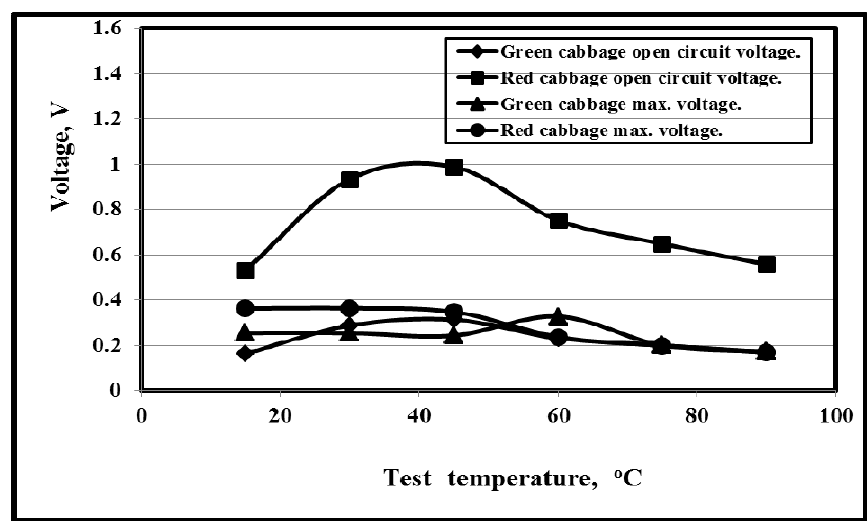
Figure 13. Vm and Voc/temp. relation for RC and GC solar cells.